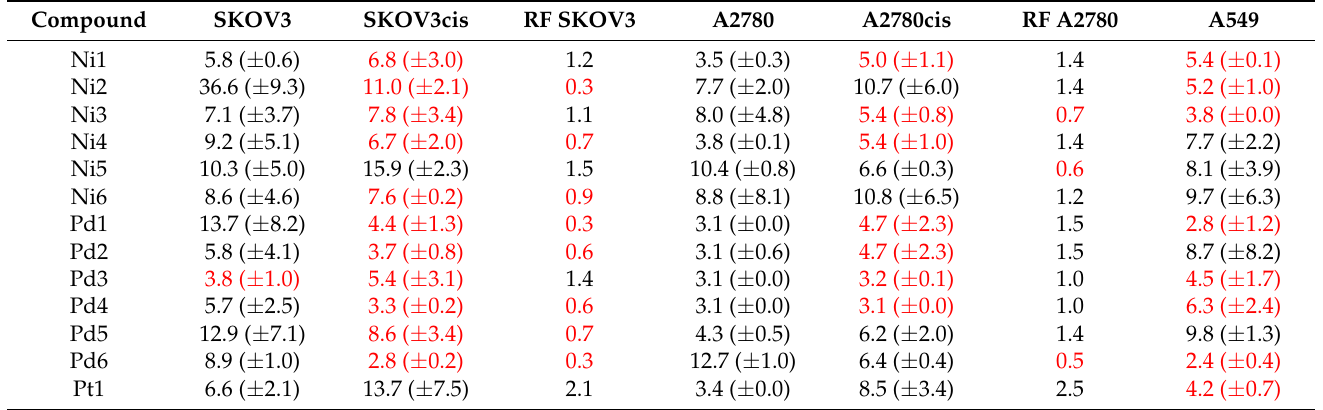
Table 4. IC 50 values [ µ M] and resistance factors (RF) for ovarian cancer cell lines and their resistant analogues (-cis), and lung cancer cell line A549 for compounds M1–6